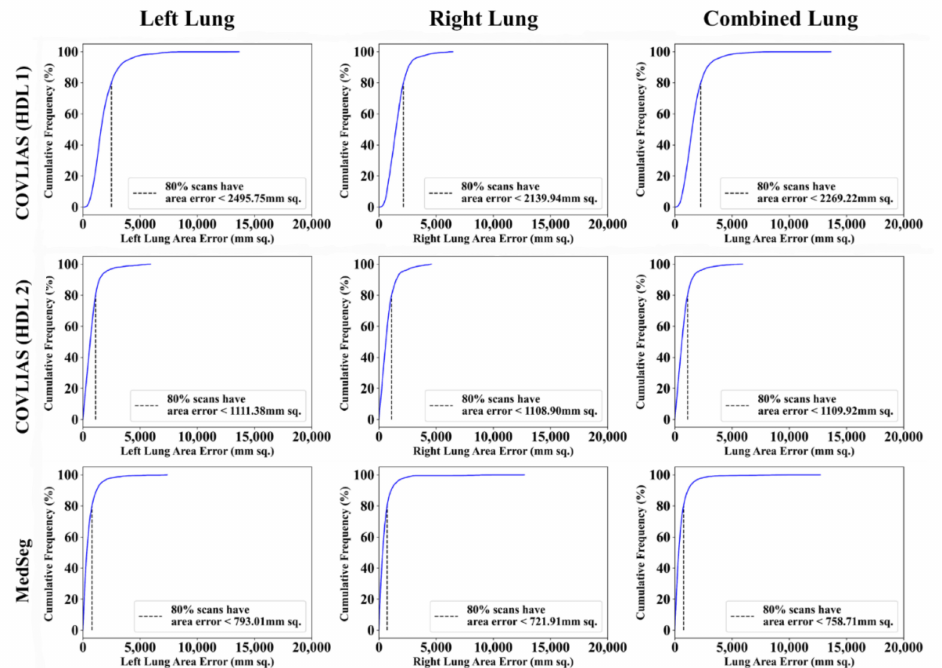
Figure 16. Cumulative frequency plots: COVLIAS (row 1 and row 2) vs. MedSeg (row 3) using MD 1. Column 1: left lung, column 2: right lung, and column 3: mean of left and right lungs. COVLIAS (HDL 1): VGG-SegNet; COVLIAS (HDL 2): ResNet-SegNet.